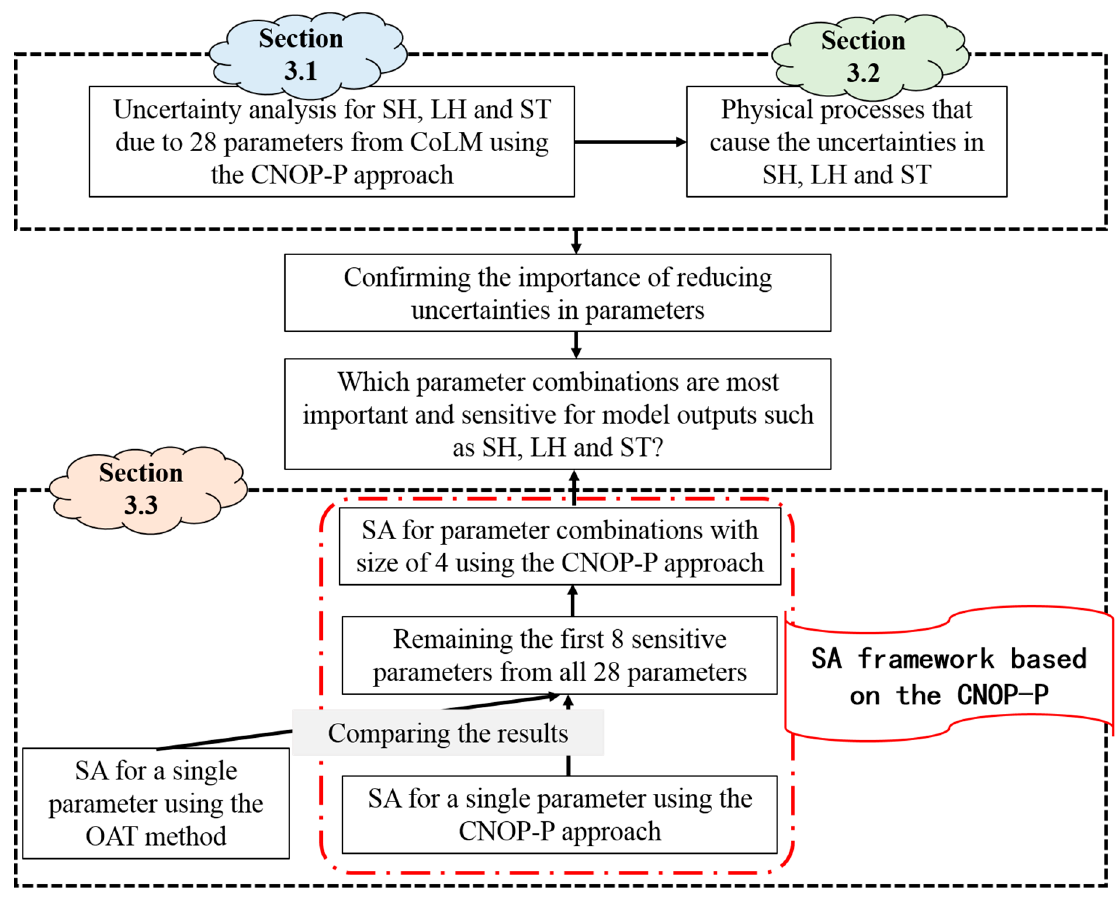
Figure 3. The flow chart of this study. SA = sensitivity analysis.